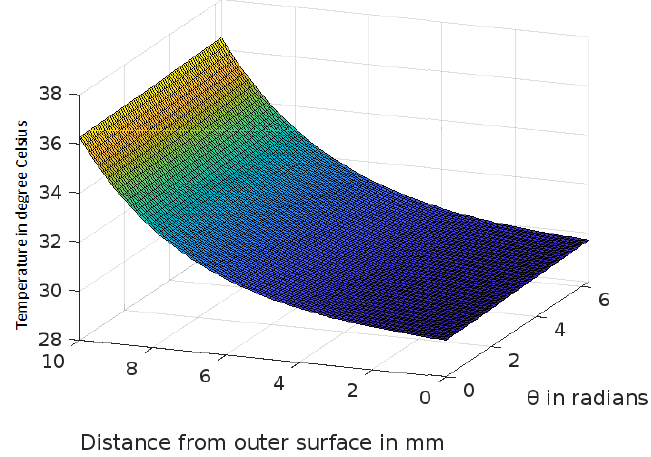
Figure 3. Variation of temperature profiles in human skin with an external temperature at the skin surface of 25 ◦ C.